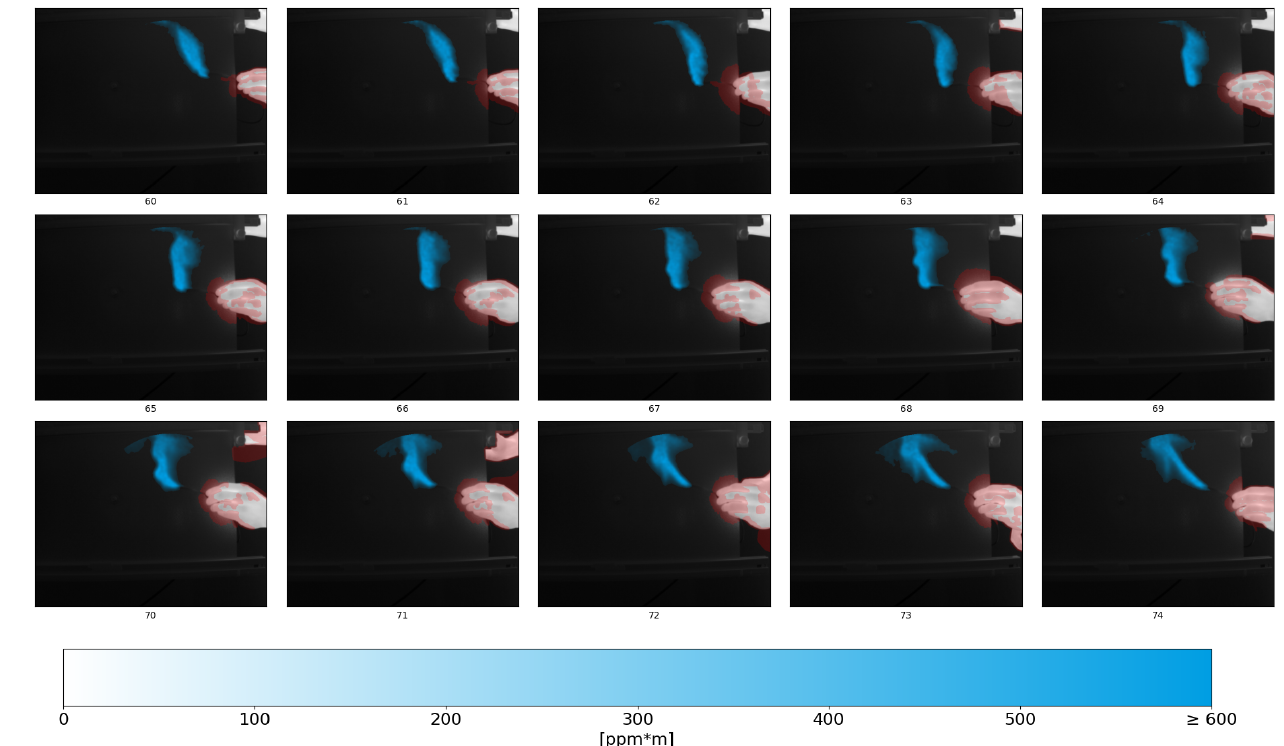
Figure 7. A total of 15 exemplary frames of a gas video are plotted (recorded with the active OGI camera). The infrared information is shown in grayscale. The methane stream is overlaid in blue, and its opacity accounts for the CL (in units of ppmm − 1 ). The red marked parts show where the frame-difference mask suppresses incorrect CL information. The video is available for download (see the Video supplement section for more